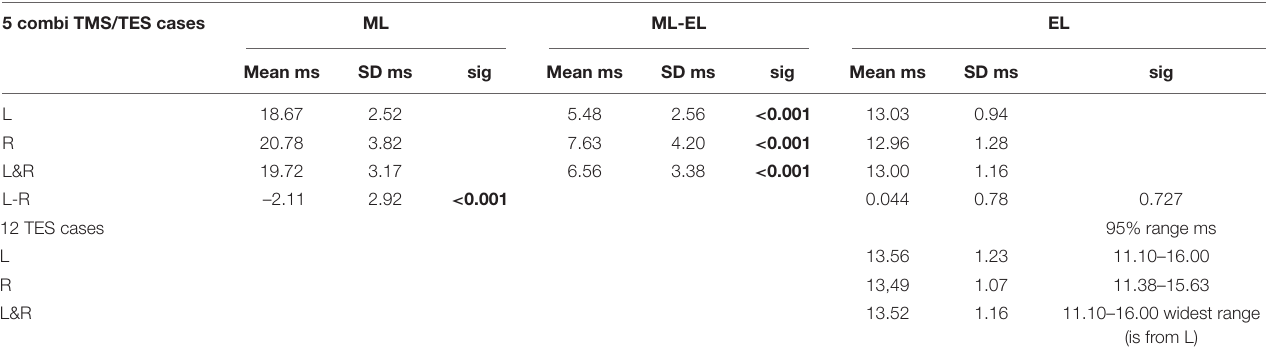
TABLE 2 | Upper part: Overview of mean and standard deviations (SD) of motor latency values for TMS (ML) and TES (EL), mean ML-EL differences with significance (sig) for left (L), right (R), combined sides (L&R) and left vs. right comparisons (L-R) of trapezius muscle MEPs with mean, SD and significance. 5 combi TMS/TES cases